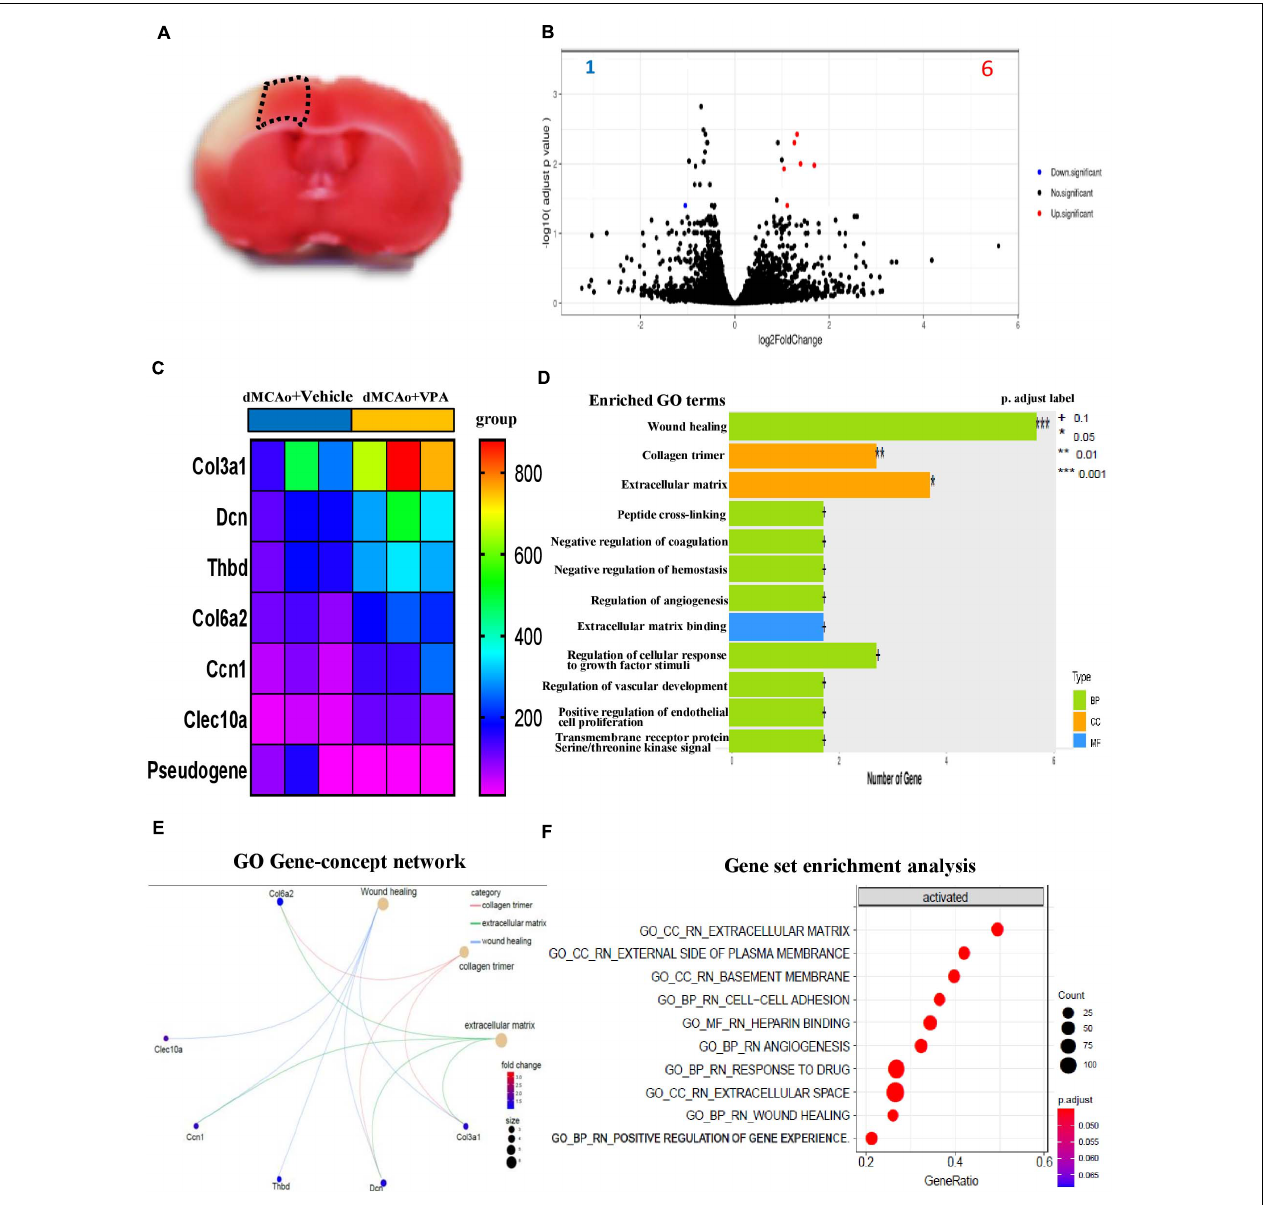
FIGURE 7 | Post-stroke VPA treatment regulates gene expression in the peri-infarct cortex at 3 days after ischemic brain injury. (A) A representative image of the brain sections used for the RNA-sequencing experiment. (B) Volcano plot comparing the log2fold changes and adjusted p -values of 15446 gene expressions. The red dots indicate genes upregulated (log2fold change > 1, adjusted p -value < 0.05), the blue dots indicate genes downregulated (log2fold change < –1, adjusted p -value < 0.05), and the black dots indicate genes with no significant change between dMCAo + vehicle and dMCAo + VPA. (C) Heatmap plot of DEGs in peri-infarct cortex between dMCAo + vehicle and dMCAo + VPA. (D) GO biological processes, cellular component, and molecular function over-representation analysis based on 7 DEGs. (E) Molecular network plot connected using GO over-representation analysis following VPA treatment in a rat model of dMCAo. (F) GO gene set enrichment analysis of genes upregulated by